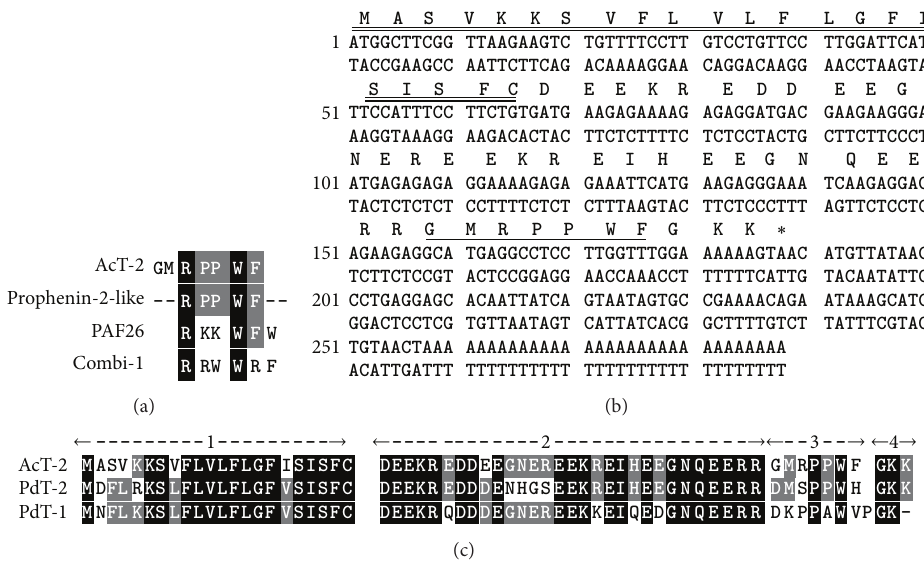
Figure 2: Comparison of the primary structure of AcT-2 with those of similar peptides. PAF26 and combi-1 are synthetic antifungal peptides isolated from combinatorial peptide libraries [12, 13]. Prophenin-2-like is a region of an antimicrobial polypeptide, cathelicidin, sequenced from a genomic DNA template of the killer whale ( Orcinus orca ) (accession no. XP004284013). Conserved amino acid residues are shaded black and consensus residues are shaded grey (a). Nucleotide and translated open-reading frame amino acid sequence of a cloned cDNA encoding the biosynthetic precursor of AcT-2. The putative signal peptide is double-underlined, the mature peptide is single-underlined and the stop codon is indicated by an asterisk (b). Alignments of complete open-reading frame amino acid sequences of AcT-2 precursor- encoding cDNA with the two top hits obtained following BLAST analysis using the NCBI portal. PdT-1 and PdT-2 represent Pachymedusa dacnicolor tryptophyllin-1 and -2, respectively. Conserved amino acids are shaded black and consensus amino acids are shaded grey. Gaps have been inserted to maximize alignments. (1) Putative signal peptide domain. (2) Acidic spacer peptide domain. (3) Mature peptide domain. (4) C-terminal processing site (c).